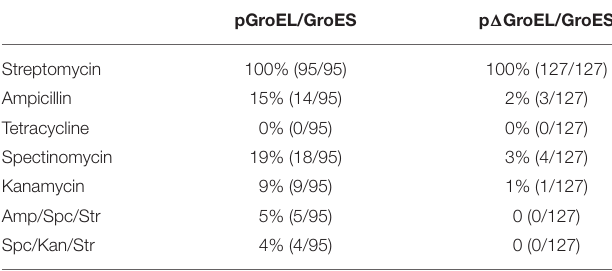
TABLE 1 | Susceptibility to other antibiotics of streptomycin selected isolates.